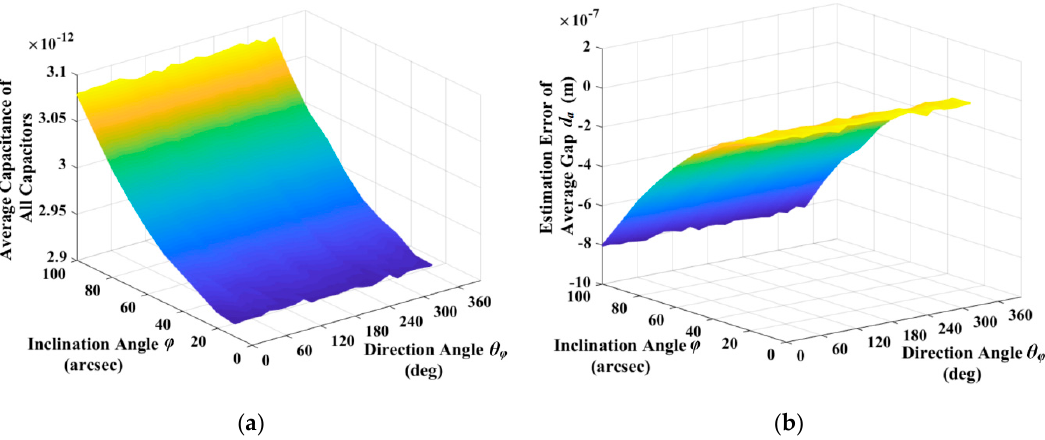
Figure 11. Average capacitance of all capacitors and estimation error of average gap a d : ( a ) Average capacitance of all capacitors with different inclination angle and direction angle; and, ( b ) Estimation error of average gap with different inclination angle and direction angle.